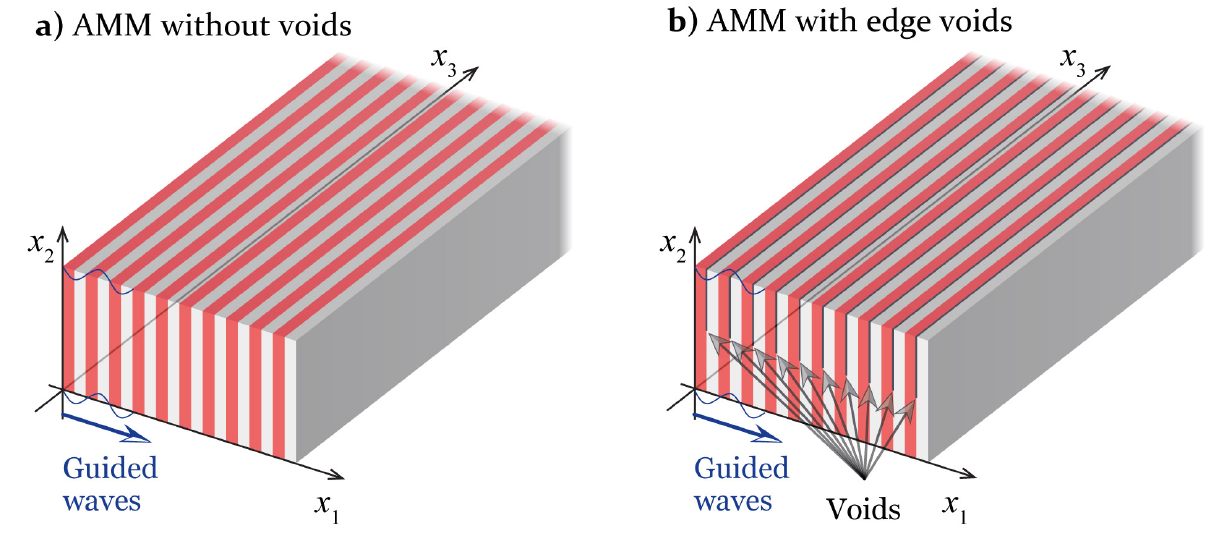
Figure 1. Design of the specimens without voids ( a ) and with edge voids ( b